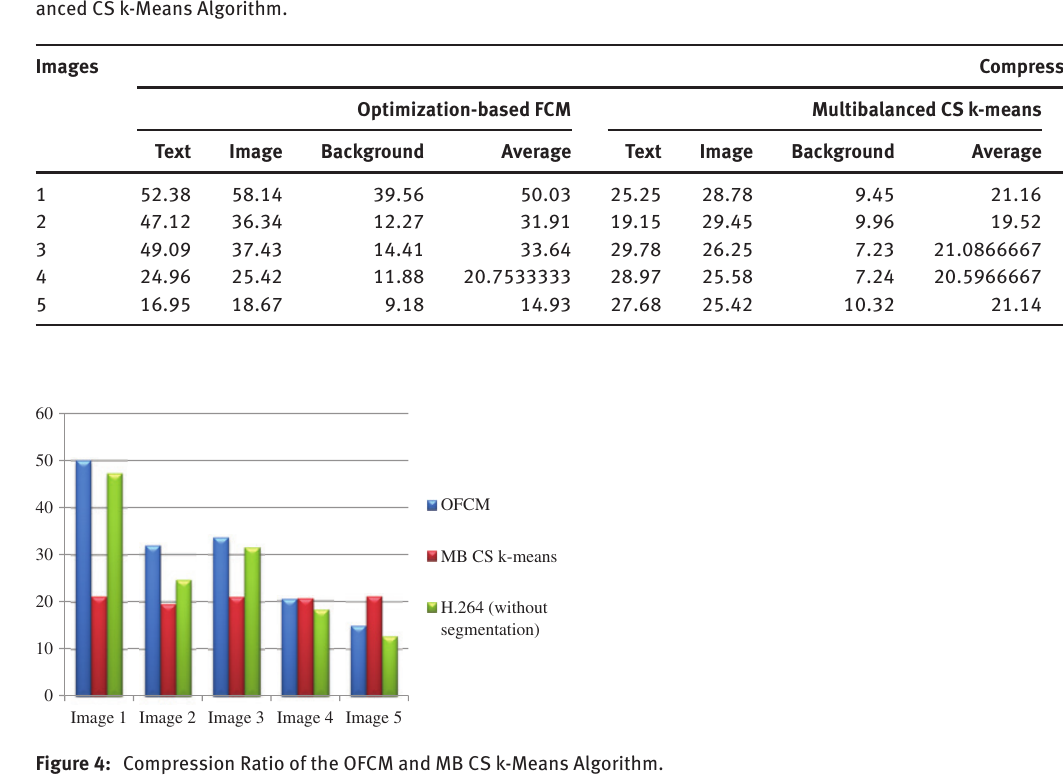
Figure 4: Compression Ratio of the OFCM and MB CS k-Means